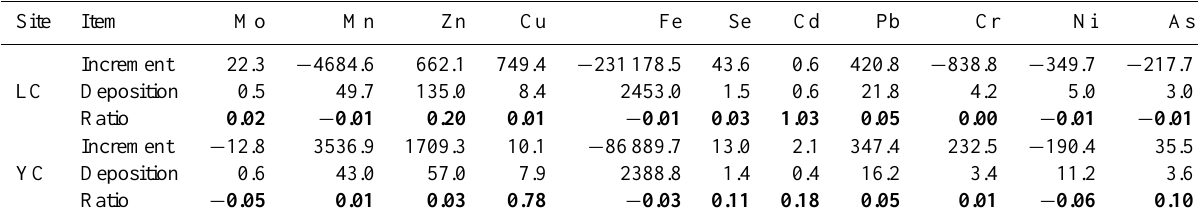
Table 6. Average enrichment (increment) of elemental content in topsoil (0–10cm) relative to deep soil (60–100cm) vs. atmospheric total deposition flux of metals at agricultural sites on an annual basis (mgm − 2 )